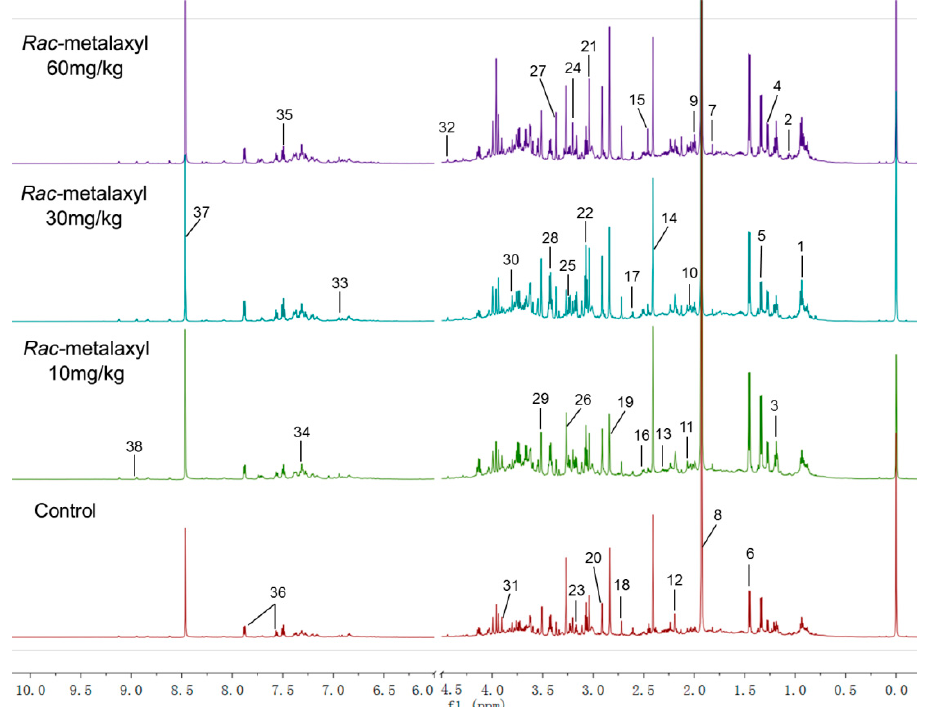
Figure 2. Representative 1 H-NMR spectra of the urine sample after rac- metalaxyl exposure: 1,